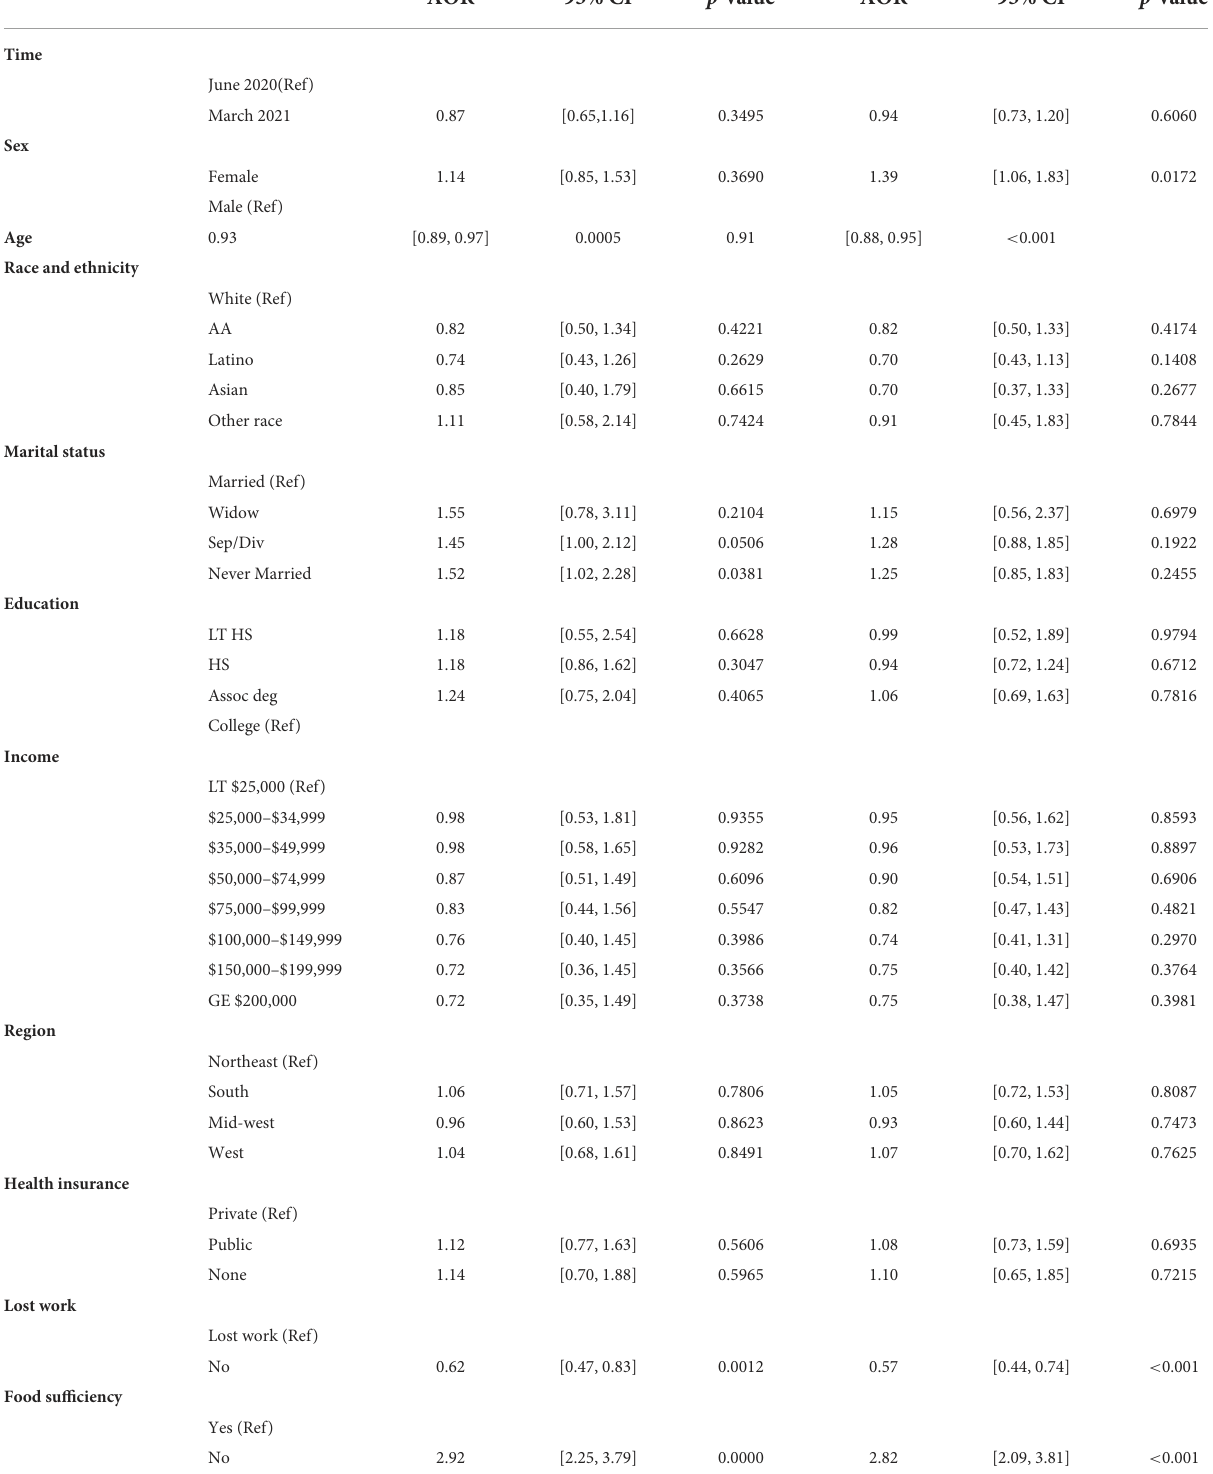
TABLE 3 Adjusted odds ratios and 95% (confidence intervals) selected characteristics from separate logistic regressions on depression and anxiety United States Census Pulse Survey–Week 7 (june 2020) and week 27 (march 2021). AOR 95% CI p -value AOR 95%